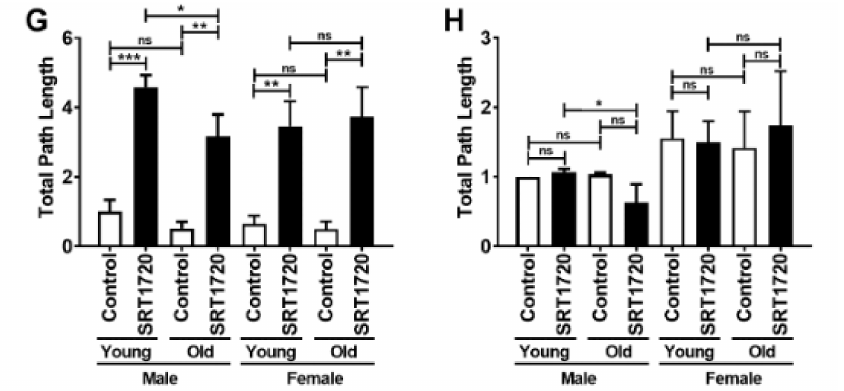
Figure 3. Angiogenesis parameters associated with ECs isolated from lungs ( A , C , E , G ) or bone marrow ( B , D , F , H ). The number of nodes ( A , B ), the number of meshes ( C , D ), the number of paths (vessel-like tubes) ( E , F ), and the total path length ( G , H ) were quantified. Young male control (vehicle treated) expression was set to 1.0 and expression in all other samples are shown relative to the young male control. Data are expressed as the mean ± SD. An unpaired Student’s t -test was used to identify statistically significant differences. n = 5 mice/sex/age. ns = not significant, * p < 0.05, ** p < 0.01, and *** p < 0.001.